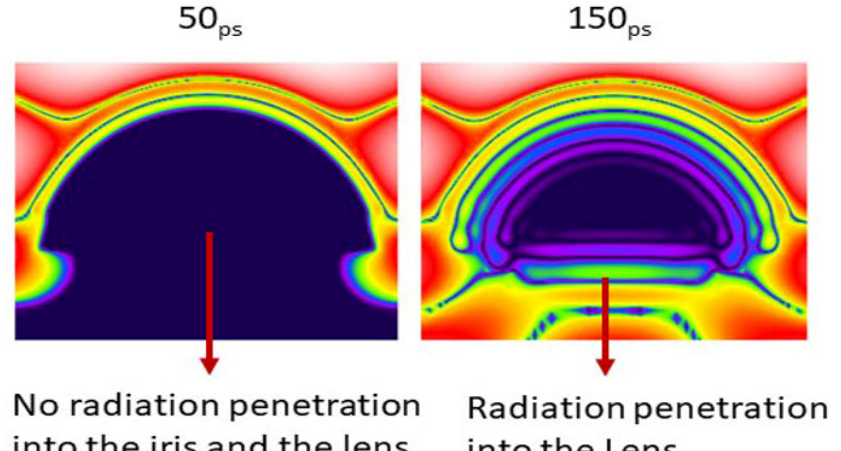
Figure 10. Radiation penetration and exposure pattern at the internal eyeball structures as time progresses; an excitation source of 30 GHz is